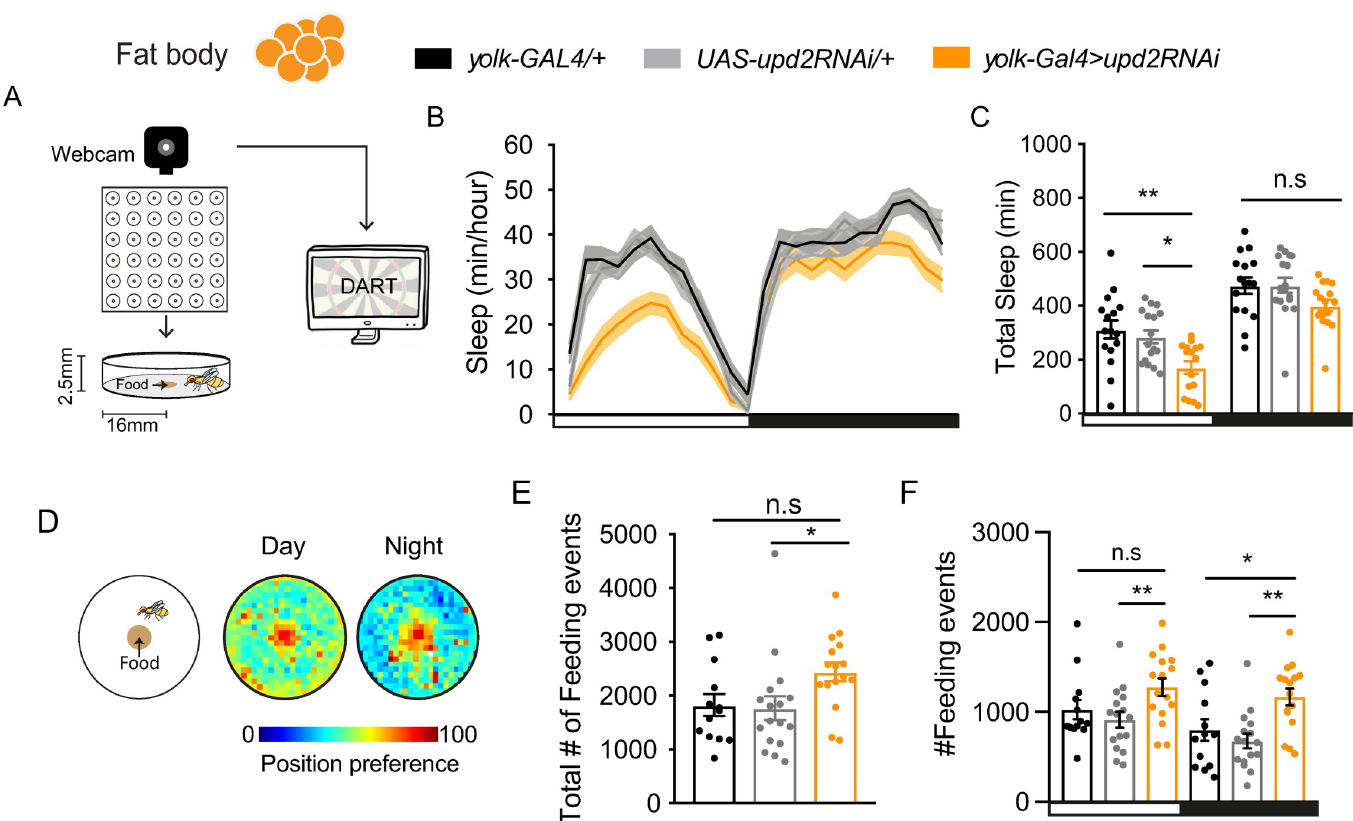
Fig 4. Simultaneous tracking of sleep and feeding-related behavior in an open-field arena. (A) Schema of the open-field tracking system. Flies are housed individually in circular arenas, radius = 16 mm. Each arena has a food cup in the center (radius = 5 mm). Fly activity is monitored via a webcam and analyzed with DART. (B) The 24-hour sleep profile of flies with upd2 knockdown (orange line) compared with genetic controls. Sleep was tracked for 3 days ( n = 15–17 per genotype) (black, yolk- GAL4/+ ; gray, UAS-upd2RNAi/+ ). (C) FB-specific upd2 knockdown in open-field arena showed a similar phenotype as in tubes (orange bars). (D) Exemplary average 2D heatmap position preference plots for day and night, warmer colors indicate a higher probability of flies being in that position. (E) Number of feeding events for each genotype over 3 days. Total feeding events in knockdown flies was only significant compared with one of the parental controls, UAS-upd2RNAi/+ . (F) upd2 knockdown flies had an increase in feeding events during nighttime. Daytime feeding count was increased, as well, but was only significantly different from one of the parental controls ( UAS-upd2RNAi/+ ). One-way ANOVA (with Tukey’s post hoc test) for normally distributed data or Kruskal-Wallis test (with Dunn’s multiple comparison test) for nonparametric data was used to compare data sets. � P < 0.05, �� P < 0.01, ��� P < 0.001; error bars show SEM. White and black bars indicate light and darkness, respectively. The data underlying this figure can be found in S1 Data. DART, Drosophila arousal tracking; FB, fat body; GAL4, galactose-responsive transcription factor; RNAi, RNA interference; UAS, upstream activation sequence; upd2 , unpaired 2.